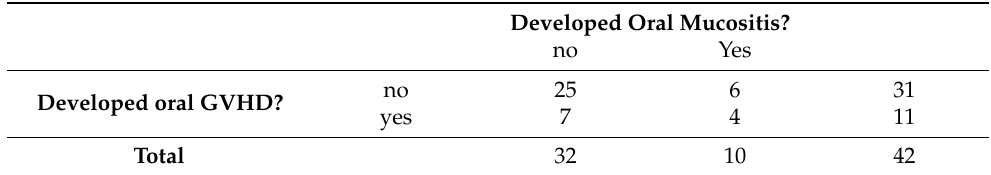
Table 2. Distribution of patients who did and did not develop oral mucositis vs patients who did and did not develop oral